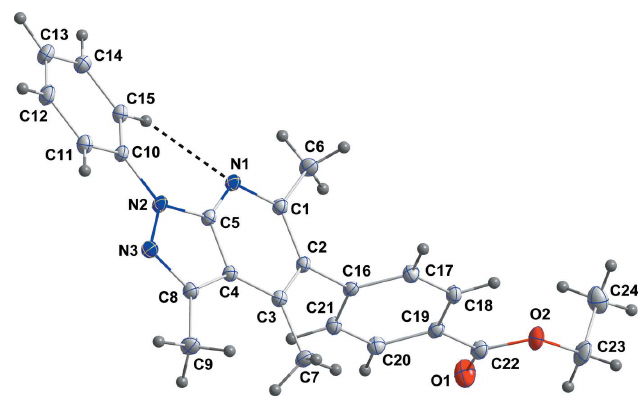
Figure 1 The title molecule showing 50% probability ellipsoids. The intra- molecular C—H (cid:3)(cid:3)(cid:3) N bond is indicated by a dashed line.